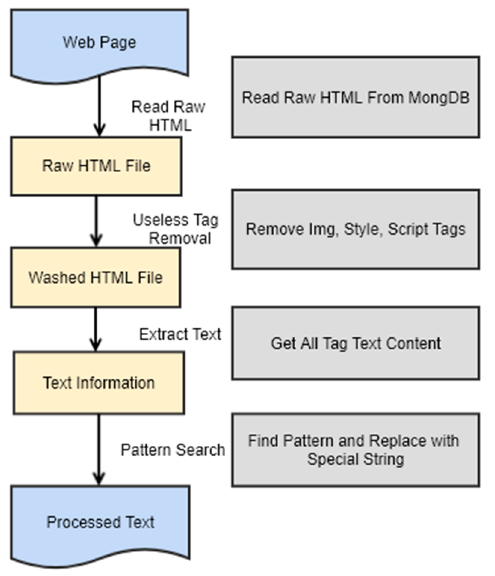
Figure 1. Web page preprocessing.